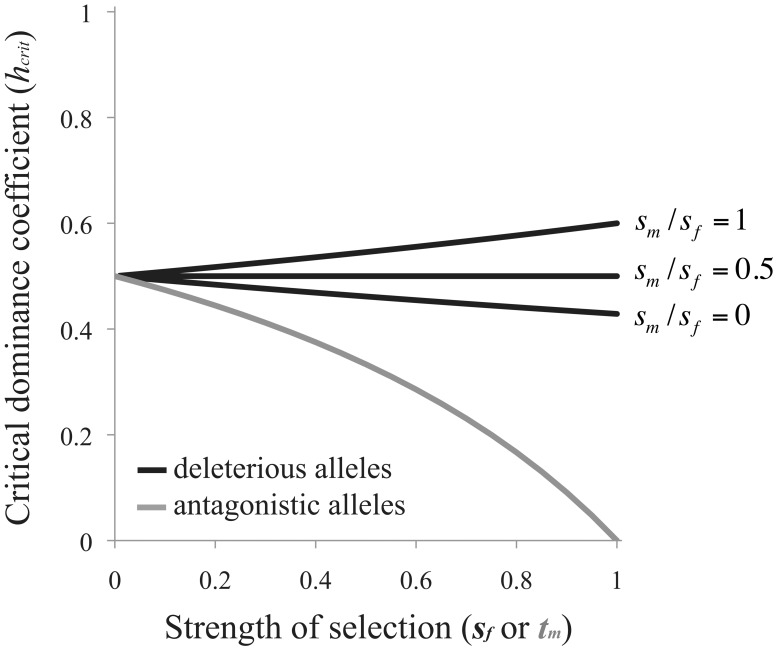
Criteria for the evolution of RXI.Black curves are based on eq. (3) for the mutation-selection balance model of genetic variation (in which case, the x-axis refers to the female selection coefficient, sf). The gray curve is based on eq. (4) for sexually antagonistic alleles maintained by balancing selection (here, the x-axis refers to the male selection coefficient: tm). The area above each curve represents parameter space where unbiased RXI is not favored over PXI. RXI is favored under the complementary parameter space below each curve.